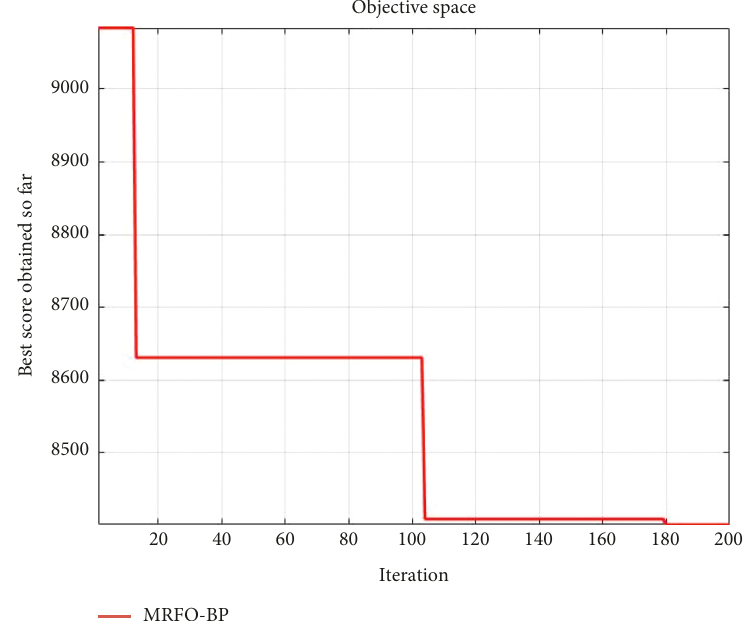
Figure 9: Historical optimal position curve of the inlet.